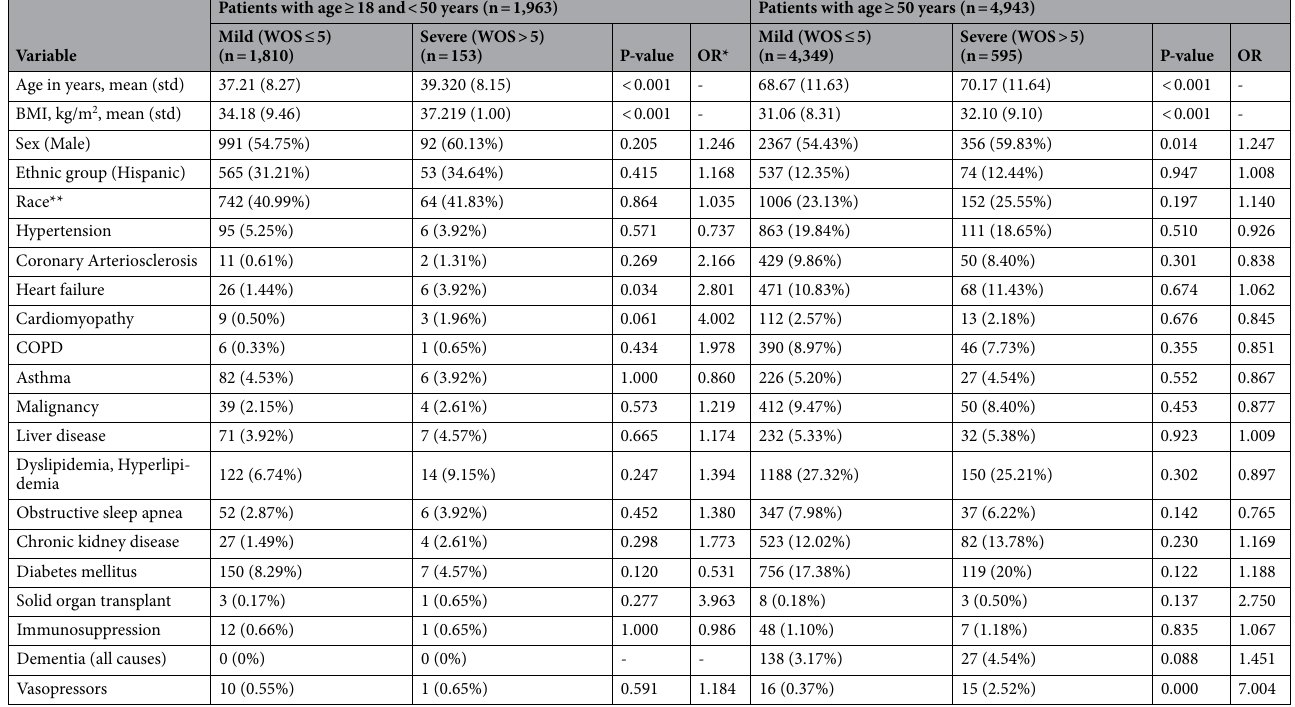
Table 2. Demographics and medical conditions among hospitalized patients with COVID-19 by severity. *OR = Unadjusted odds ratio. **American Indian, Alaska Native, Asian, Black or African American, Native Hawaiian or other Pacific Islander,